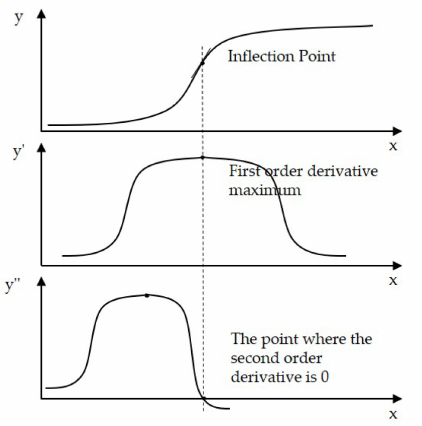
Figure 6. Significance of the second-order derivative of the logistic